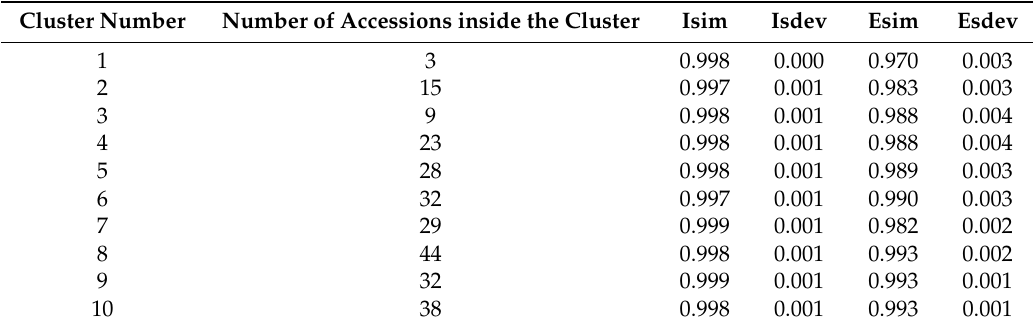
Table 5. Clustering analysis of 253 sugarcane accessions with morphological traits based on repeated bisection (RB) method.